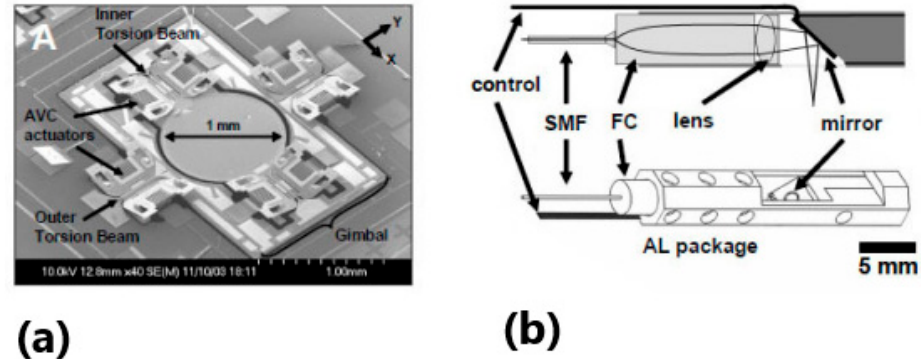
Figure 9. SEM photograph of 2D MEMS scanner in ( a ) and the schema of MEMS catheter packaging in ( b ) (Figures from [47]).